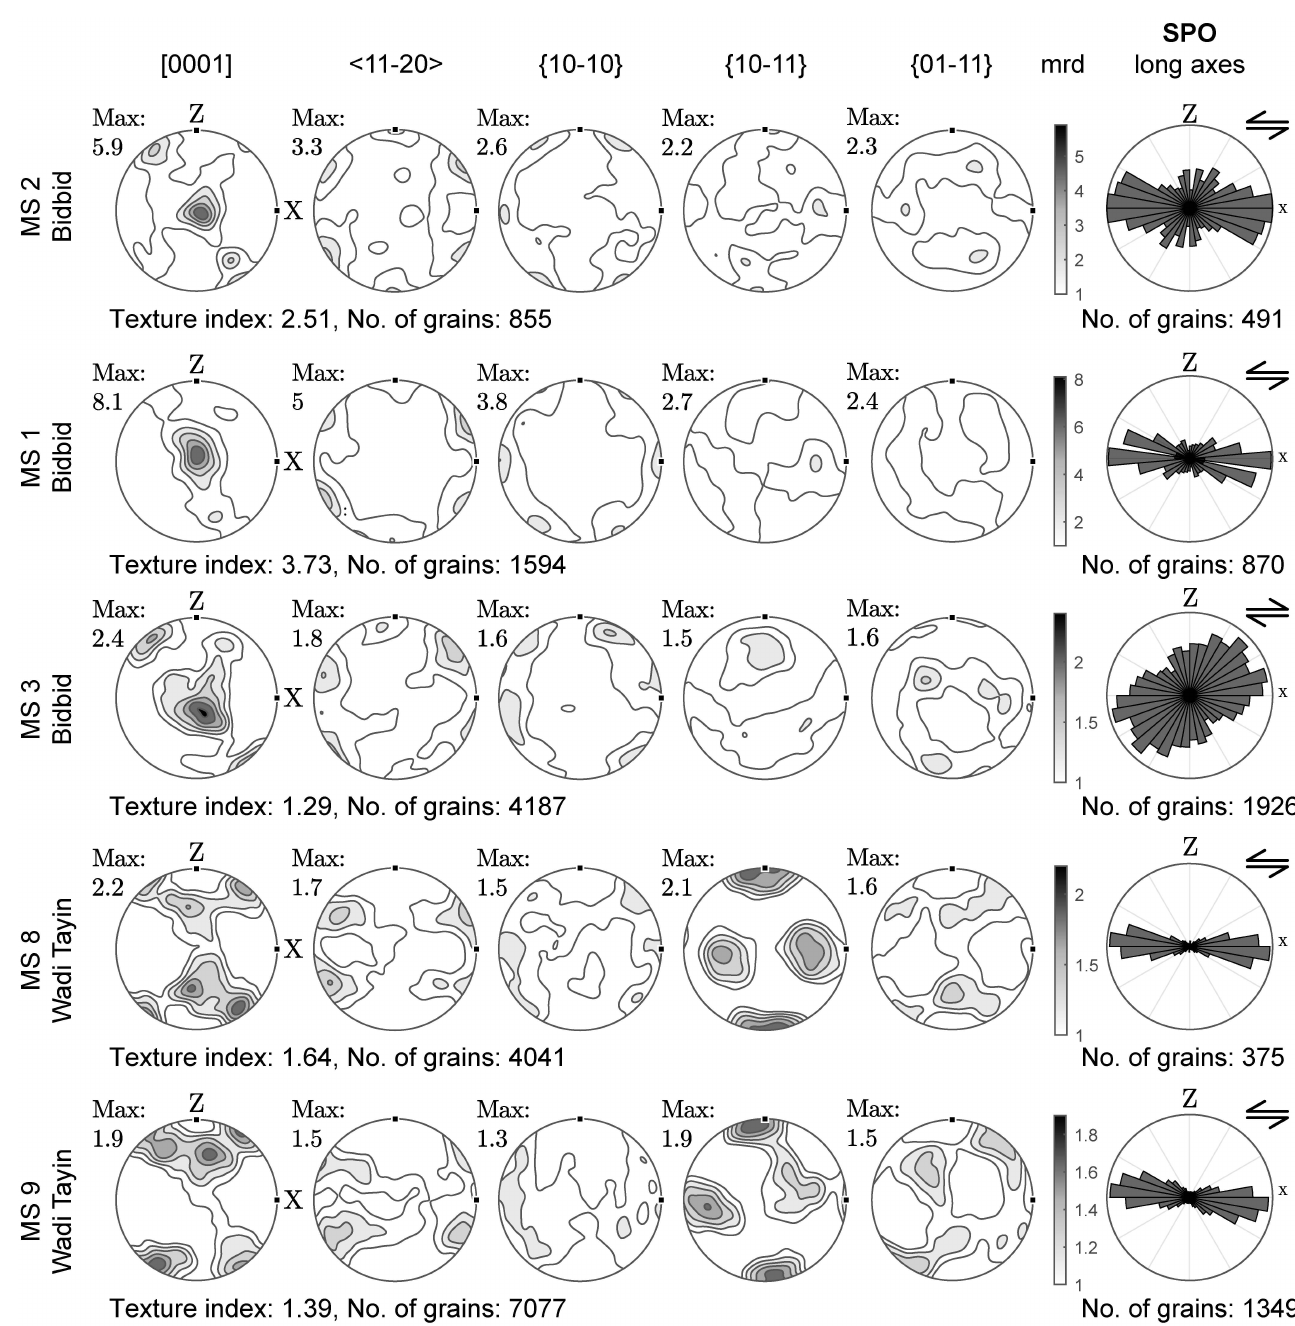
Figure 6. Quartz pole figures from EBSD measurements with one orientation per grain. Sections are perpendicular to the foliation and parallel to the X direction of the finite strain ellipsoid (S-N for MS 1, 2, and 3 and SW-NE for MS 8 and 9). All pole figures are plotted antipodally and in the upper hemisphere; m.r.d.: multiples of random distribution, max: maximum of magnitudes of m.r.d. The rose diagrams at the right represent the SPO of the grain long axes (grains >20 pixels). At the top right is the derived shear sense. Note that the shear sense of MS 3 is in the opposite direction to all other